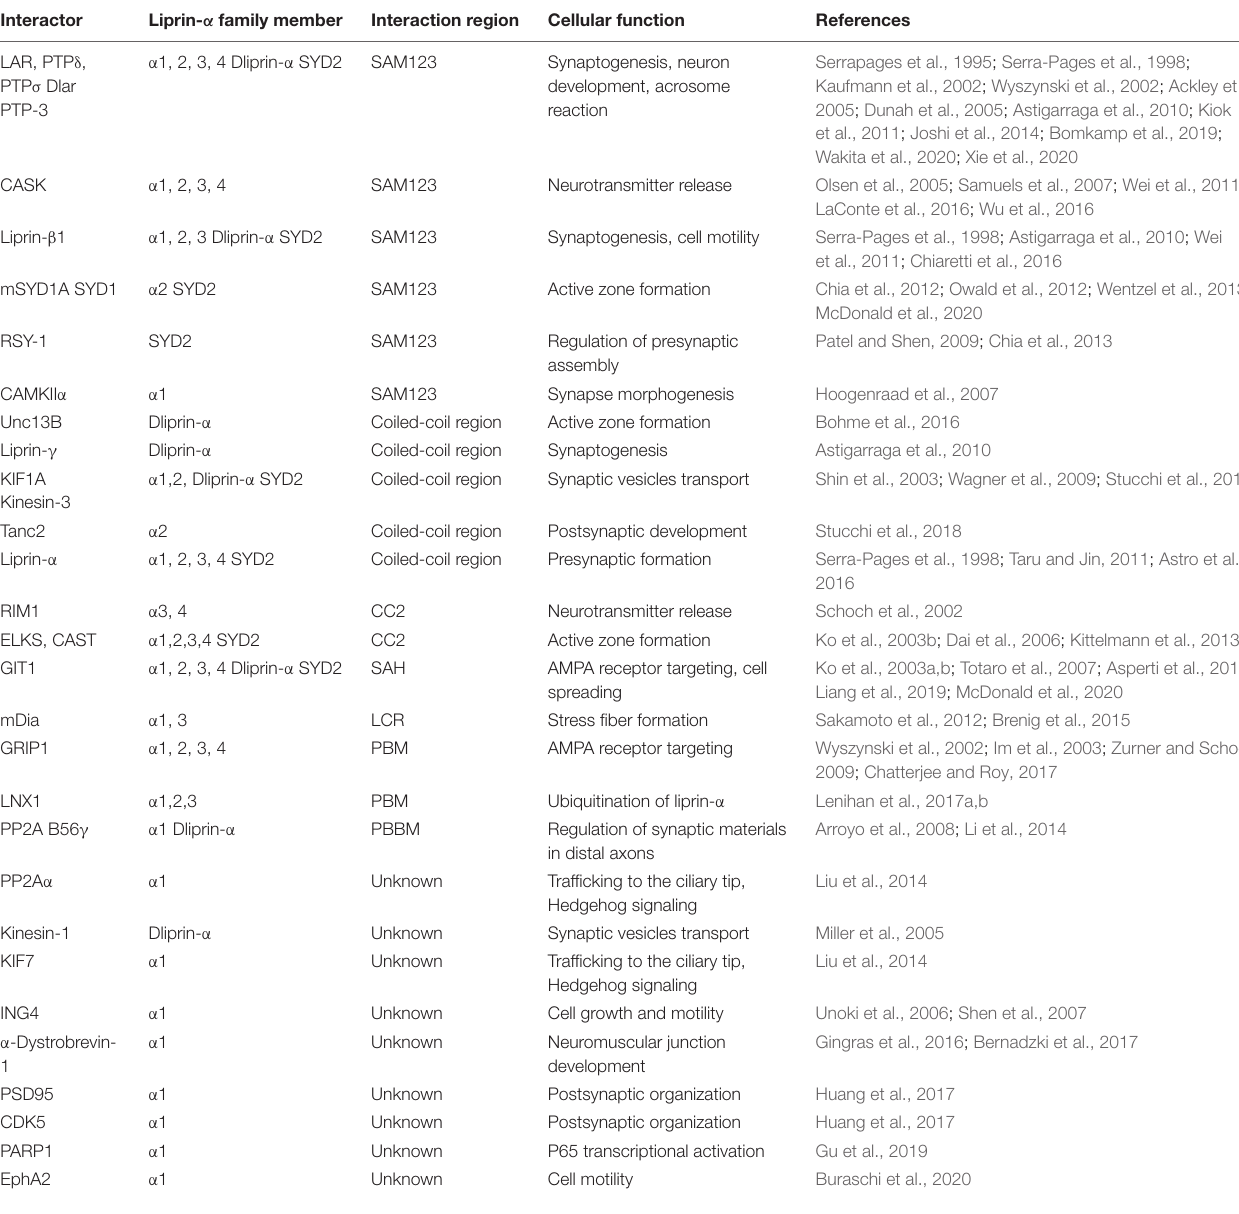
TABLE 1 | Interactions meditated by liprin- α family